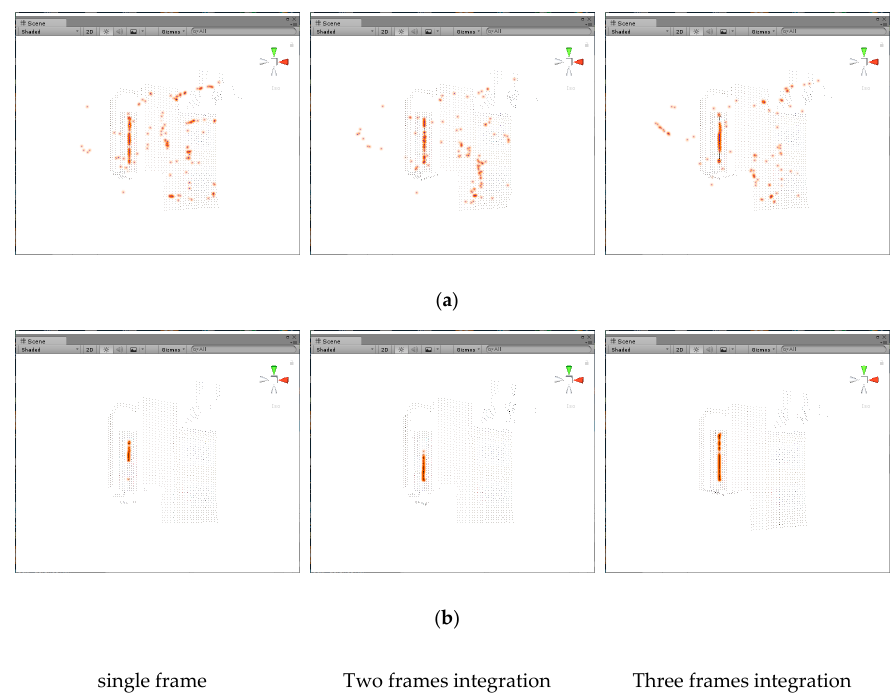
Figure 11. Center axis estimation through multiple frames: ( a ) results of the sphere fitting of each frame; ( b ) results of the central axis estimation with noise filtering through integrating the results of ( a ) with one or more frames.